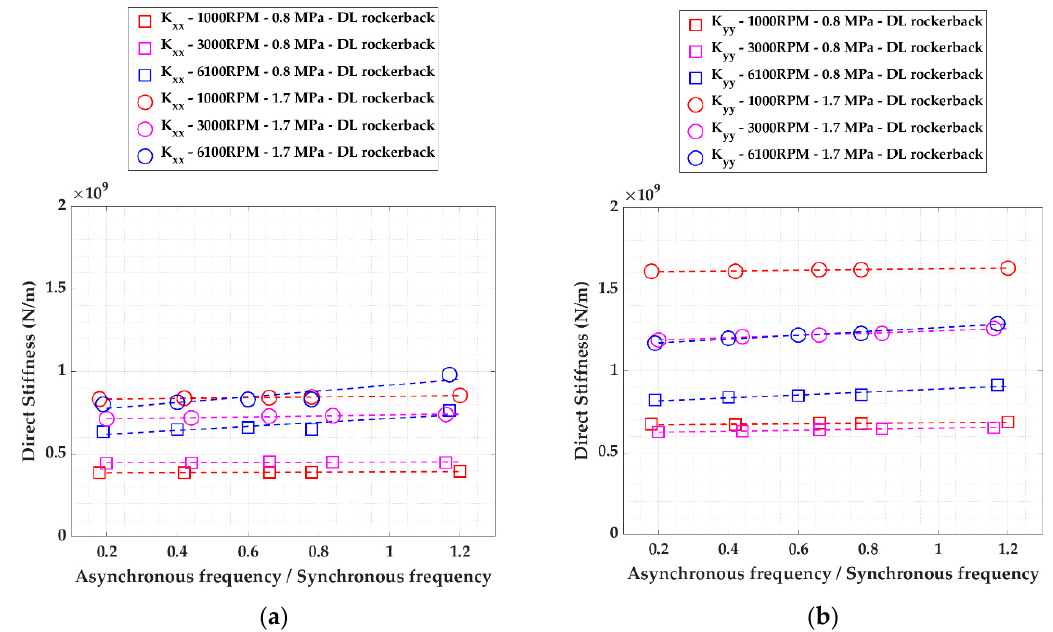
Figure 25. Direct Lube Rocker Pivot bearing asynchronous direct stiffness coefficients at various speeds for 0.8 MPa and 1.7 MPa: ( a ) K xx , ( b ) K yy .